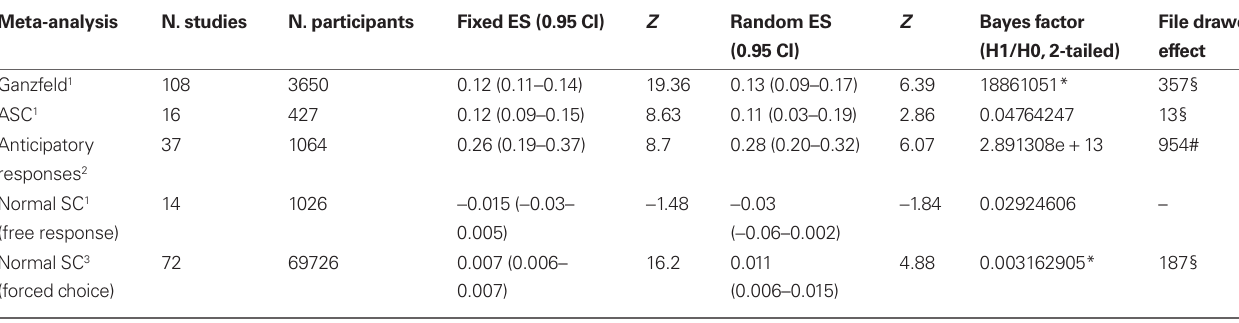
Table 1 | Descriptive and statistical results of the five meta-analysis with all raw data.